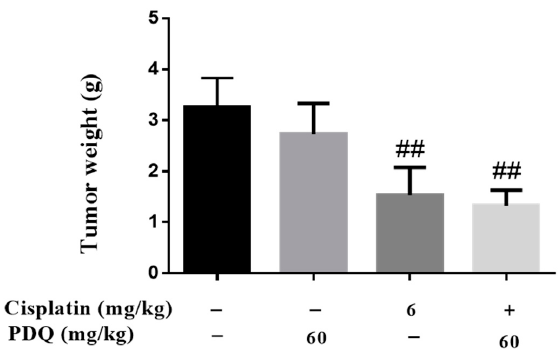
Figure 10. Effects of PDQ on the antitumor activity of cisplatin against Lewis lung cancer xenograft tumors in C57BL/6 mice. n = 10, ## p < 0.01 vs. model control group.